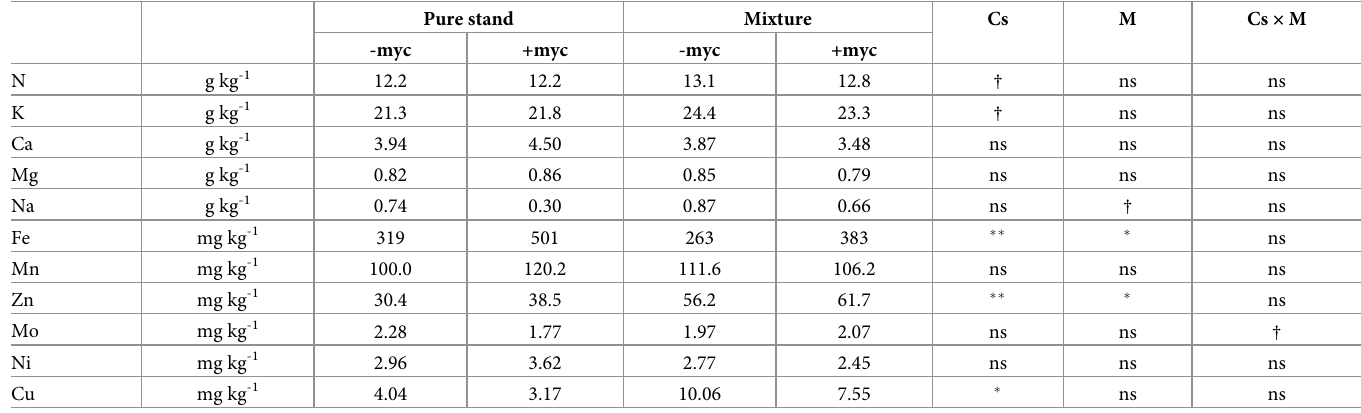
Cu mg kg -1 ns Data are means of 5 replicates. †